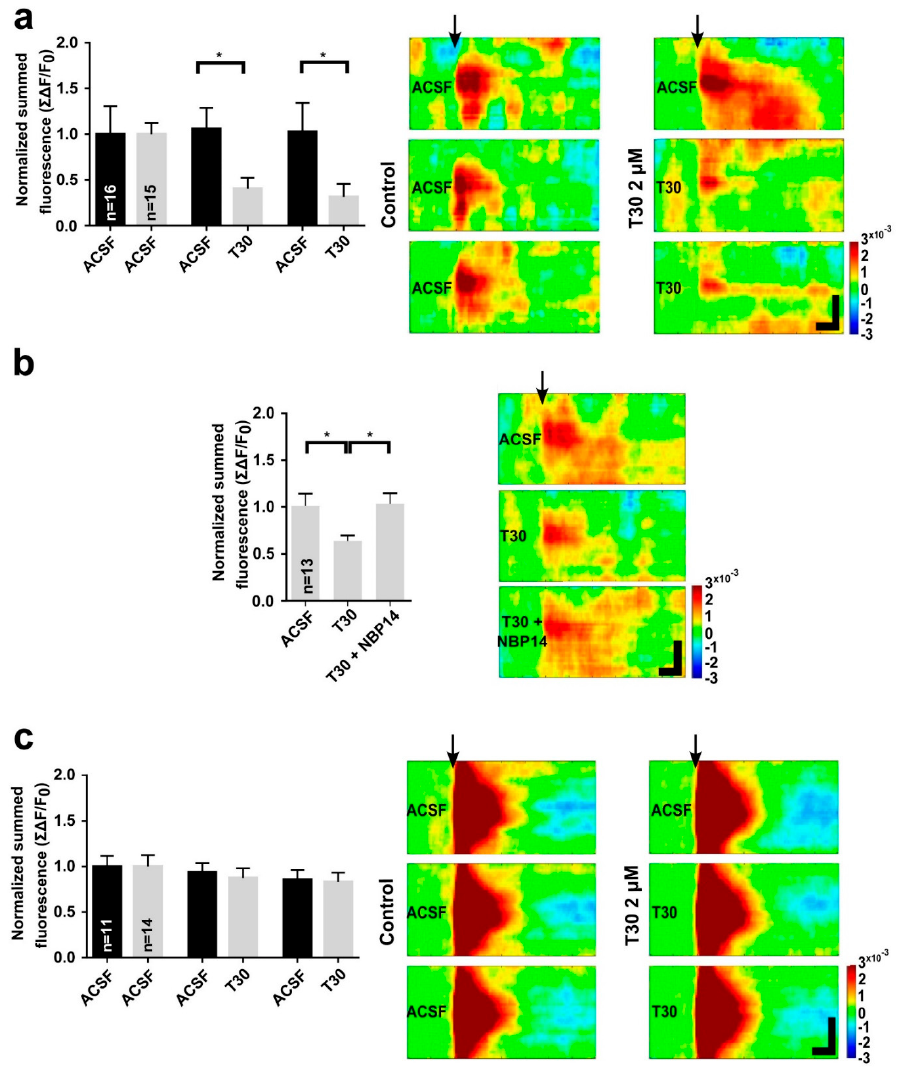
Figure 3. Optical imaging of the substantia nigra ( a , b ) or striatum ( c ) with a voltage sensitive dye (Di − 4 − ANEPPS) in rat brain slices at postnatal day 21. The response to electrical stimulation in the three sequential epochs (see Section 4) is shown as summed data in bar graphs (sequence from left to right) and as space-time maps (sequence from top to bottom). ( a ) The presence of T30 (2 µ M) caused a significant attenuation of the electrically evoked response (grey bars) compared with control recordings (black bars) made in the presence of artificial cerebrospinal fluid (ACSF) alone (One-way ANOVA, F (1.503, 21.04) = 7.74, p = 0.0055; post hoc Fisher’s LSD test, p < 0.05). ( b ) Including NBP14 (4 µ M) with T30 (2 µ M) prevented attenuation of the evoked response (One-way ANOVA F (1.819, 21.82) = 3.555, p = 0.0499; post hoc Fisher’s LSD test, p < 0.05). ( c ) When the striatum was exposed to T30 (2 µ M), the electrically evoked response was unaffected. The black arrows mark the onset of the stimulus in the space-time maps, for which the horizontal and vertical scale bars represent 50 ms and 1 mm, respectively. Data are the mean ± SEM. n = (hemislices, rats). For ( a ): n = (16 or 15, 4). For ( b ): n = (13, 4), For ( c ): n = (11 or 14, 3). * p <